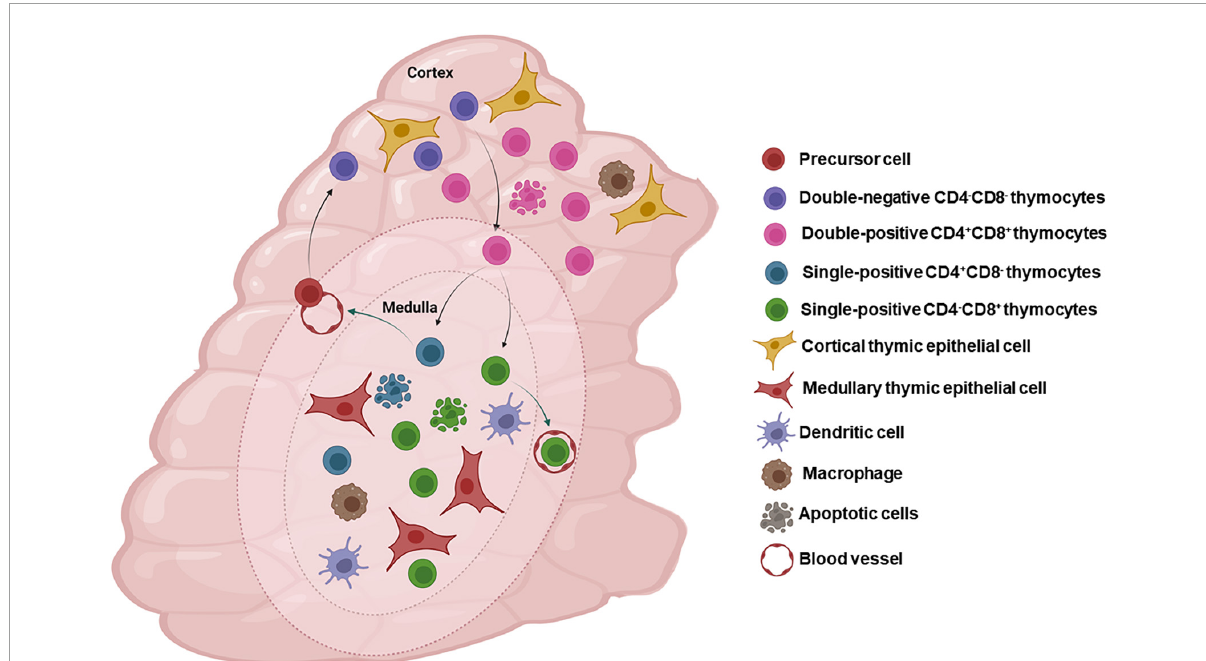
FIGURE2 The thymic microenvironment and normal intrathymic T-cell differentiation. The panel schematically depicts in a concise way, the general process of thymocyte differentiation, in the context of the thymic microenvironment. Bone marrow-derived precursors enter the organ through blood vessels in the corticomedullary junction and migrate toward the outer cortex where they proliferate, but do not express the CD3/TCR complexes as well as the accessory molecules CD4 and CD8. There CD4/CD8 double-negative cells (DN) evolve to express TCR and become CD4 + CD8 + (double-positive cells) and, under the control of the thymic microenvironment, undergo positive selection, with positively selected thymocytes migrating toward the medulla, where a large majority will die by negative selection, though apoptosis, and are ultimately resorbed within the organ by macrophages. Mature CD4 + or CD8 + single-positive thymocytes will eventually leave the organ to colonize the T-cell regions of peripheral lymphoid organs. Most thymocytes interact with microenvironmental cells in the cortical and medullary regions of the thymic lobules. Figure created with